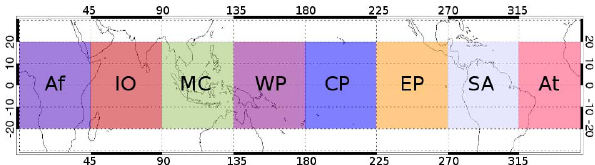
Fig. 1. The 8 tropical domains used for seasonal and regional tracer transport analysis; Africa (Af), Indian Ocean (IO), Maritime Con- tinent (MC), West Pacific (WP), Central Pacific (CP), East Pacific (EP), South America (SA) and Atlantic (At). All domains are of equal size of between 20 ◦ N–20 ◦ S and 45 ◦ in